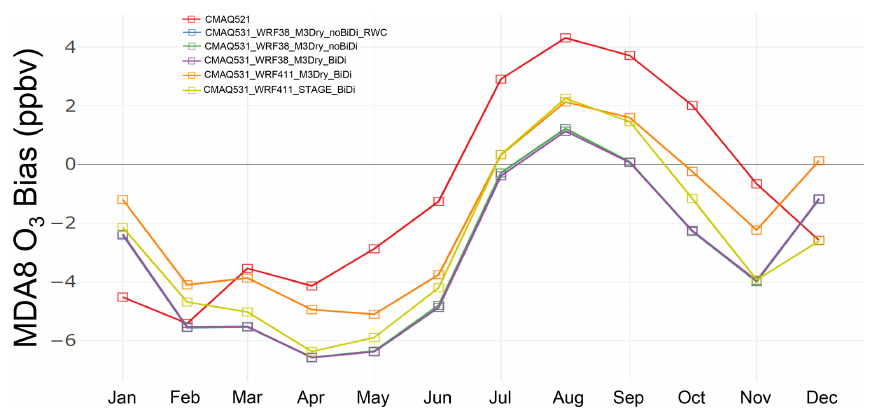
Figure 5. Time series of monthly average MDA8 O 3 bias (ppbv) compared against all AQS sites. Note that the blue, green, and purple lines all fall very close to one